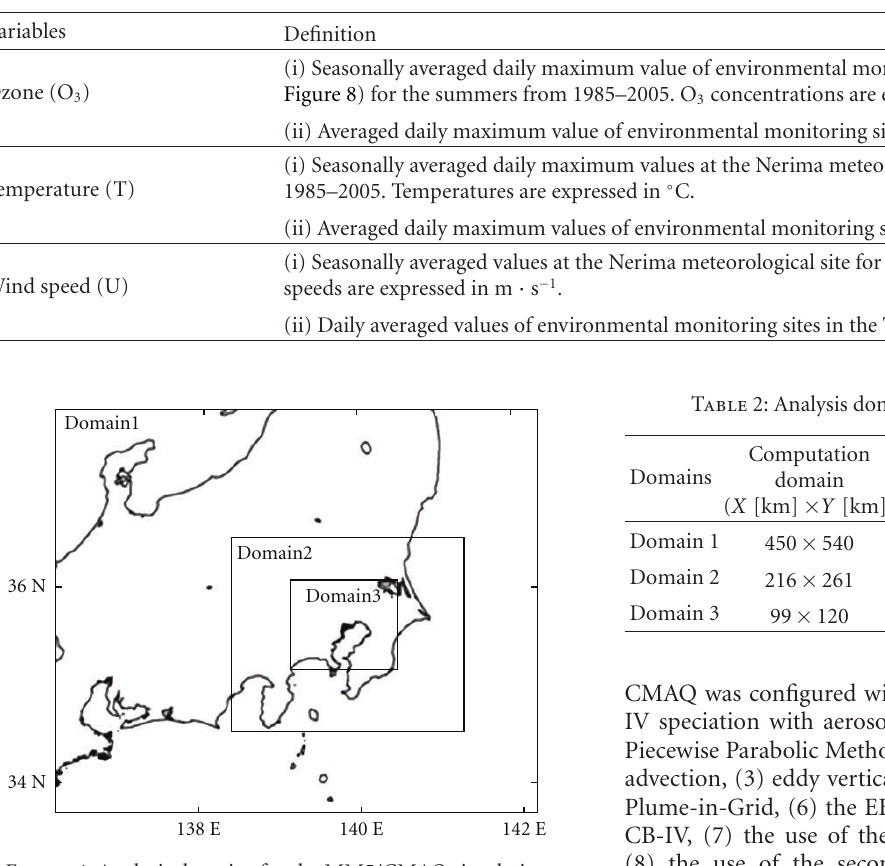
Figure 4: Analysis domains for the MM5/CMAQ simulation.